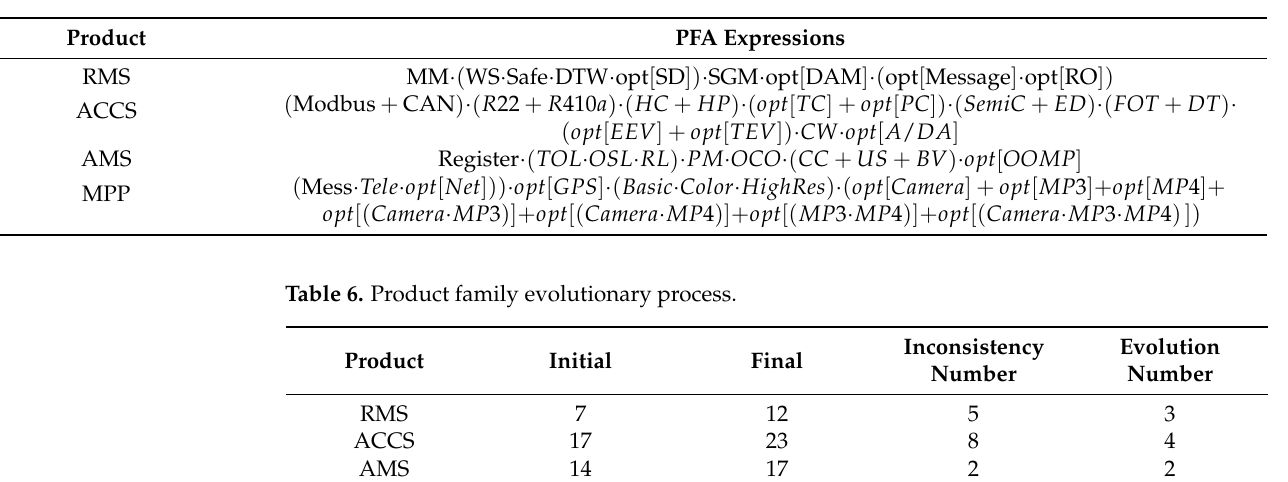
Table 5. Example system product family PFA expressions.